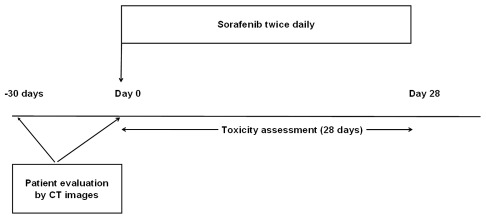
Study timelines.